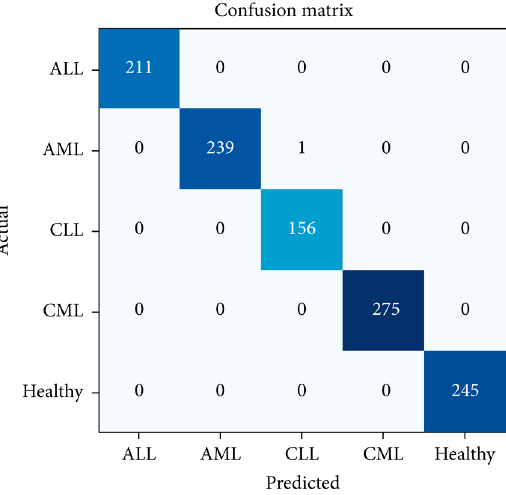
Figure 3. Confusion matrix of DenseNet-121 for leukemia subtype classi fi cation (Bibi et al., 2020) [26] .